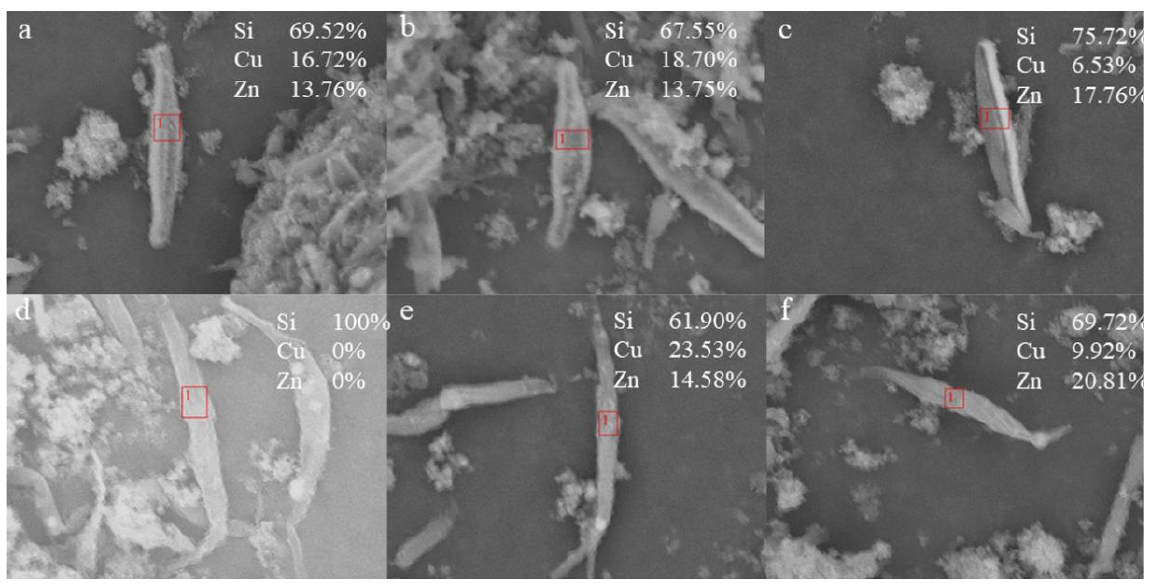
Figure 3. EDS analysis of P. tricornutum ( a – c ) and C. fusiformis ( d – f ) under different Cu 2+ or Zn 2+ concentrations (control, 5 μM Cu 2+ , and 30 μM Zn 2+ ) recorded on TM4-EDS. The box in the figure indicates the area scanned by EDS. The data in the figure reflects the percentage of Si, Cu, and Zn elements.